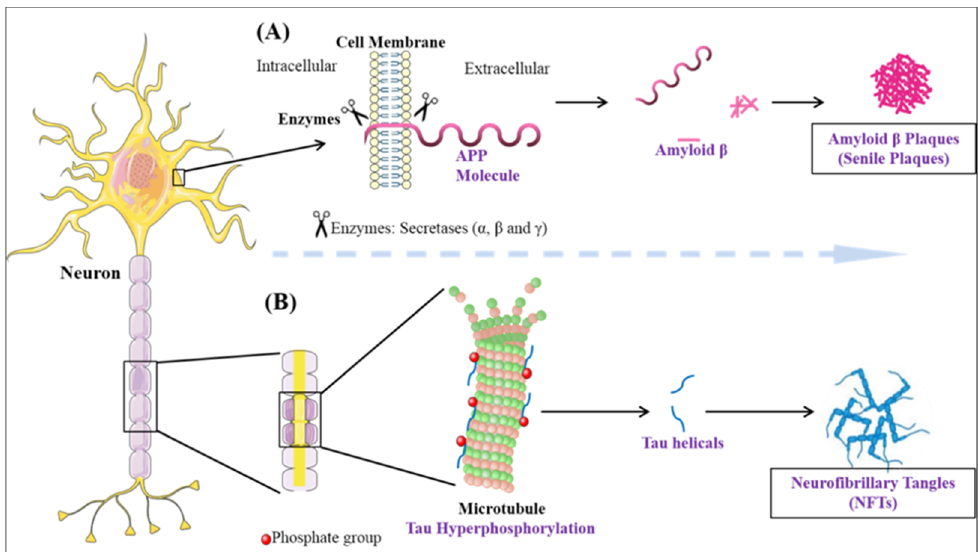
Figure 3. The neuropathological hallmarks of Alzheimer’s disease: ( A ) formation of amyloid-beta plaques ( B ) formation of neurofibrillary tangles.